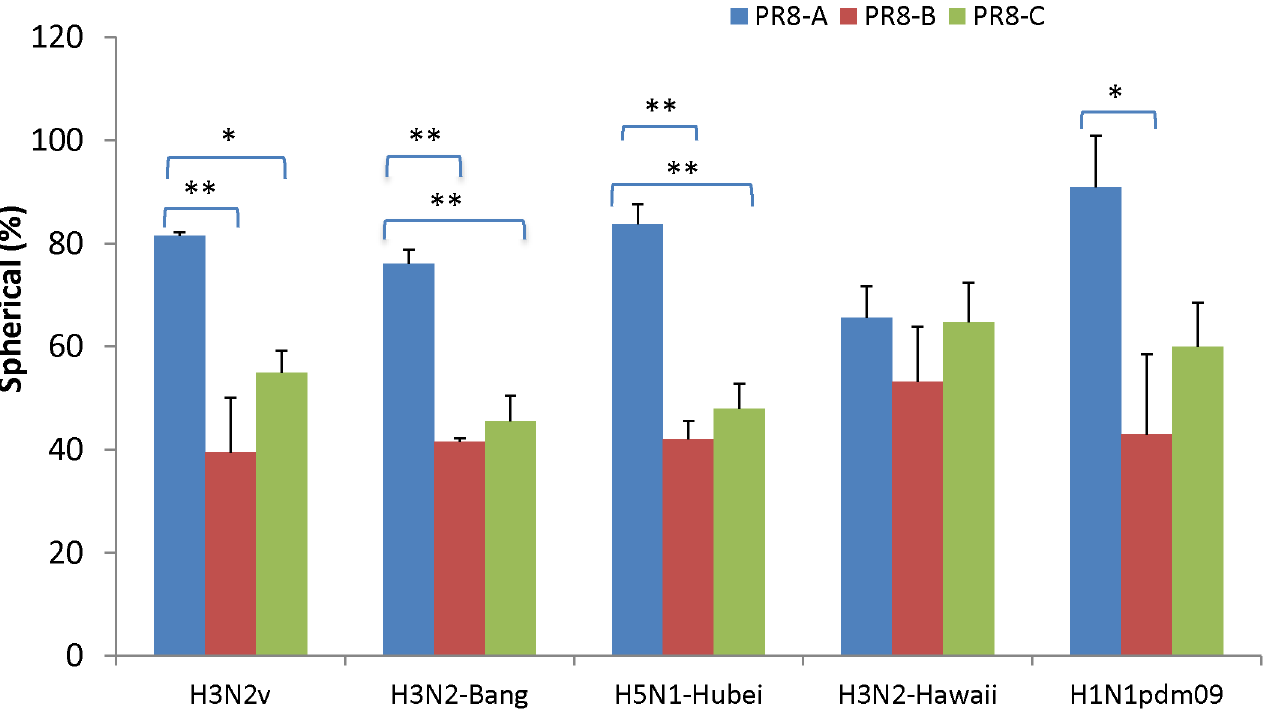
Fig 1. Percentage of spherical virions from reassortant viruses. Reassortant viruses were propagated in embryonated eggs, fixed in 2.5% paraformaldehyde and analyzed by NSEM. A total of 250 virus particles from each reassortant virus were analyzed. Virus particle with axial ratio < 1.5 is scored as spherical virion. Statistical significance was assessed as described in Materials and Methods ( * , P < 0.05; ** , P < 0.01).